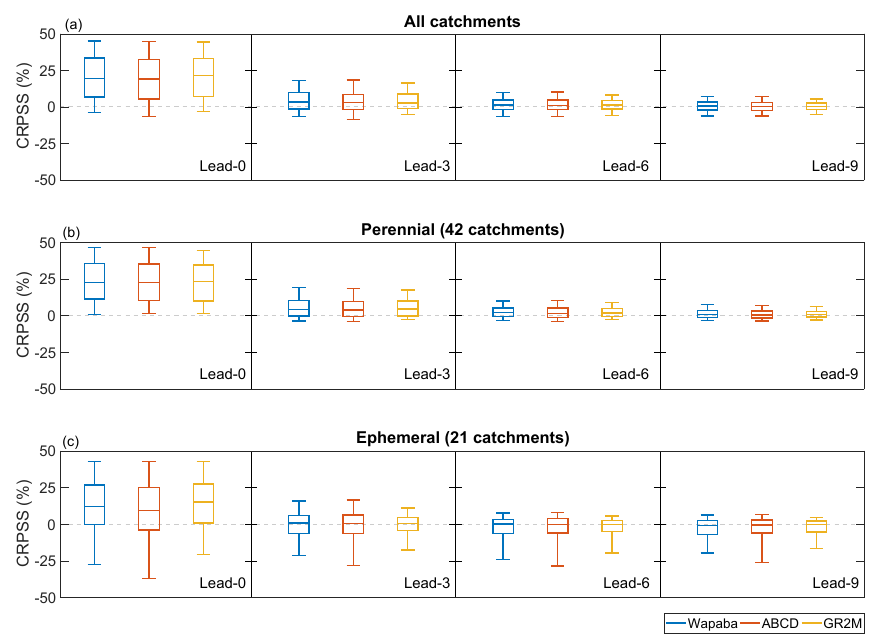
Figure 9. Skill (CRPSS) in 63 catchments by lead time for FoGSS forecasts with different rainfall–runoff models. For each lead time, forecast skill is summarized for all months with box and whisker plots. Boxes show the interquartile range with the median; whiskers give the 10th and 90th percentiles. (a) shows all catchments, (b) shows perennial catchments, and (c) shows ephemeral catchments.